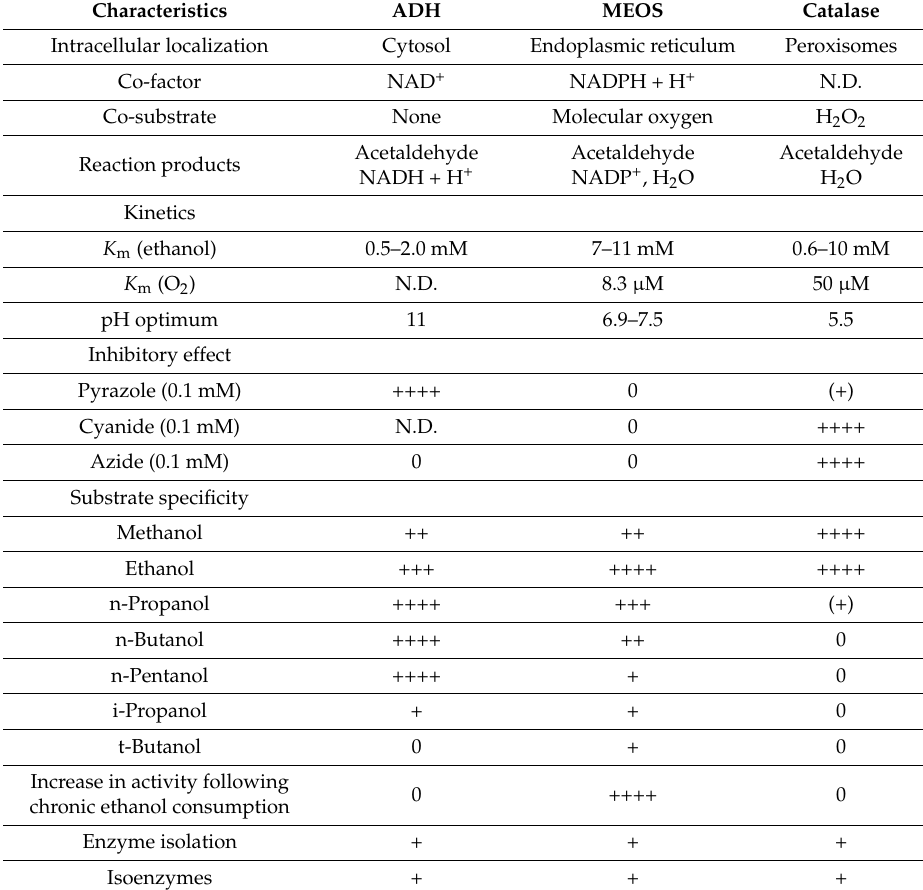
Table 1. Differentiation between ADH, MEOS, and catalase. Symbols for effects: (+), marginal; + low; ++, moderate; +++, high; ++++, very high. Abbreviations: ADH, alcohol dehydrogenase; K m , Michaelis-Menten constant; MEOS, microsomal ethanol-oxidizing system; N.D., not determined. The original table was published in a previous report [25] and is reproduced with permission of the Publisher Taylor & Francis (Didcot,